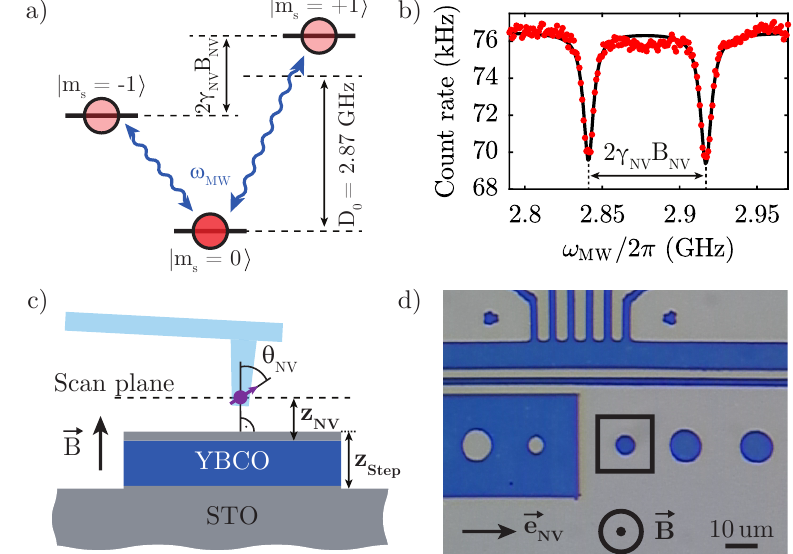
Figure 1. ( a ) Nitrogen-Vacancy (NV) centre ground state spin levels with zero-field frequency splitting D 0 and Zeeman splitting 2 γ NV B NV (with γ NV = 28 GHz/T and B NV the magnetic field along the NV axis). As indicated by the red circles, the | m s = 0 (cid:105) spin sub-level exhibits a higher fluorescence rate than | m s = ± 1 (cid:105) . ( b ) Optically detected electron spin resonance (ESR) of a single scanning NV centrer. ( c ) Schematic cross-section of the sample and the scanning probe hosting the NV centrer. The NV is stabilised at a distance z NV from the superconductor surface using atomic-force distance control. ( d ) Top view of the micro-structured YBCO sample. Blue (grey) represents regions of YBCO (substrate), respectively. The highlighted disk with 6 µ m diameter is used here to study Meissner screening and